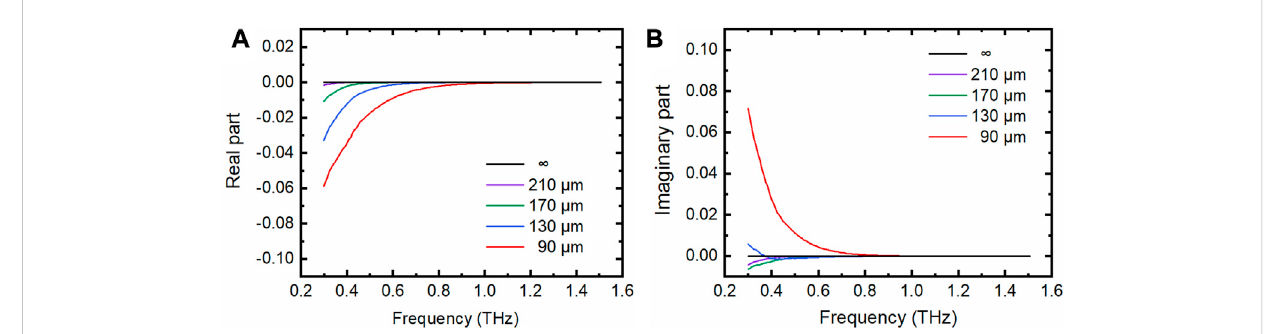
FIGURE 4 The real parts and imaginary parts of the depth-related term. (A) Real parts of the depth-related term ~ Φ . (B) Imaginary parts of ~ Φ . The cavity depth (purewaterthickness)includes90,130,170,and210 μ m “ ∞ ” indicatesthethicknessofpurebulkwater,forwhicheithertherealpartortheimaginarypart of ~ Φ is zero for the frequency range investigated.